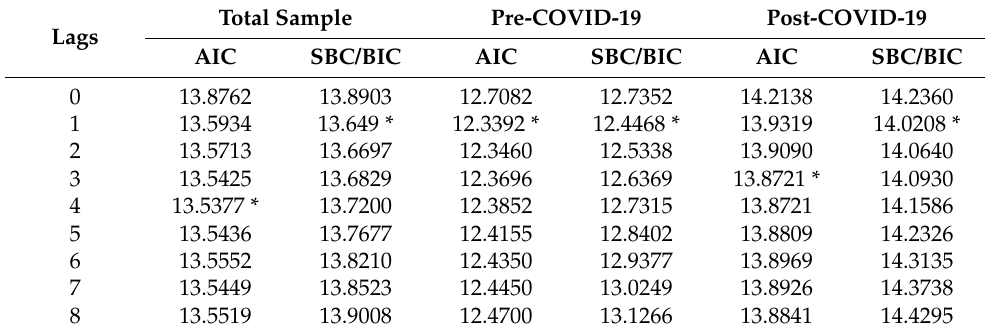
Table 8. Lag selection for VAR (p)